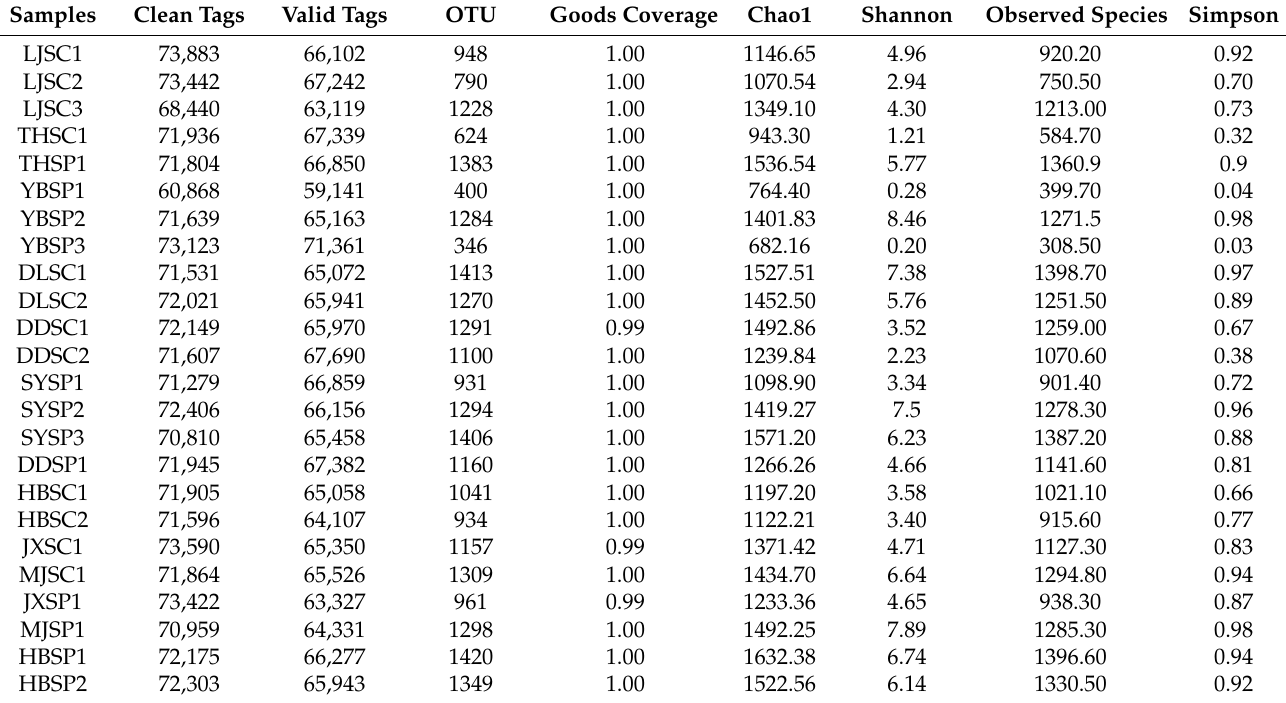
Table 3. Number of clean tags, Good’s coverage, observed OTUs, and alpha diversity estimators of 24 CSC